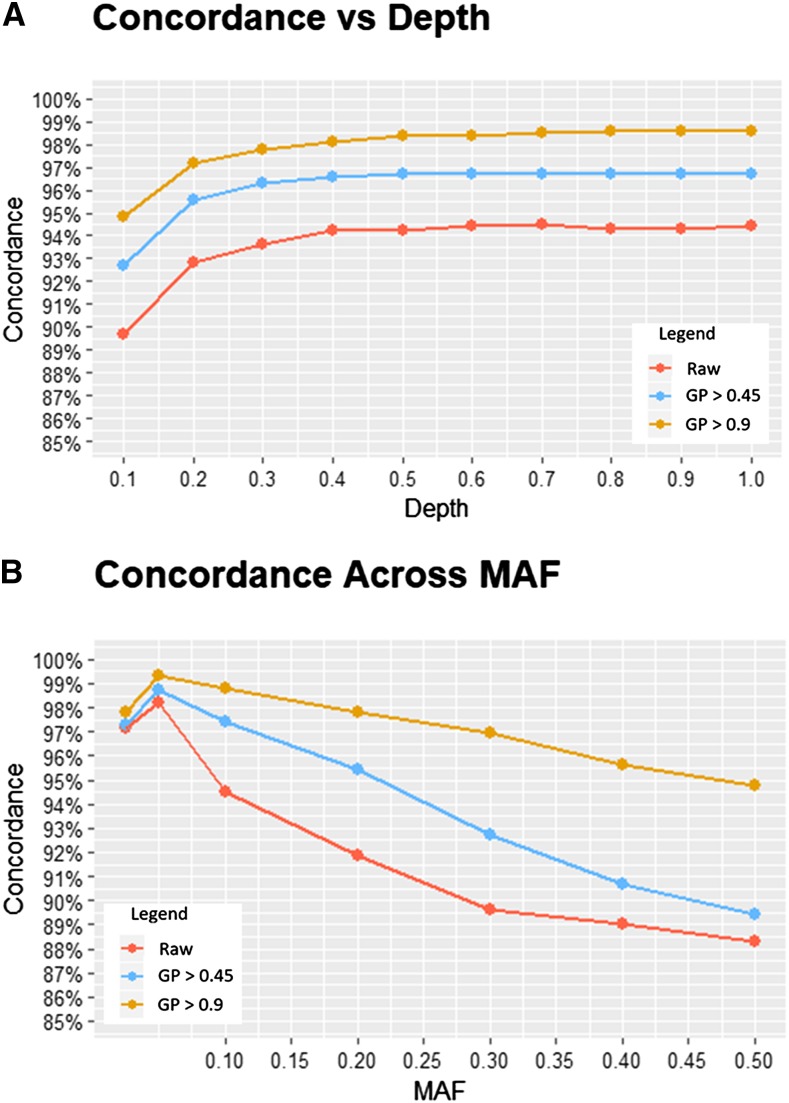
A) Overall accuracy of filtered and raw imputed datasets were plotted across the evaluated depths. For all study panels, concordance rapidly erodes below a sequencing depth of ∼0.3X. B) Examining accuracy in the context of minor allele frequency (MAF) reveals that error occurs at higher rates as MAF approaches a maximum of 0.5.